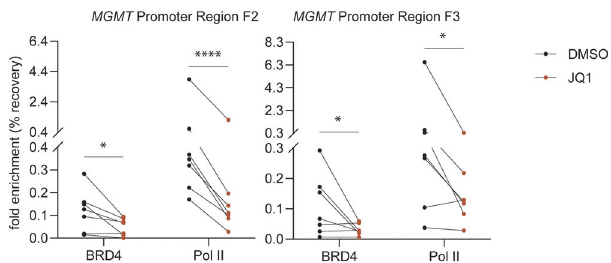
Fig. 3 BRD4 occupancy at the MGMT promoter region is reduced upon JQ1 treatment. T98G cells were treated for 2 h with or without [1 µM] JQ1. ChIP-qPCR for BRD4 and Pol II occupancy in the promoter region of MGMT interrogated at both F2 and F3